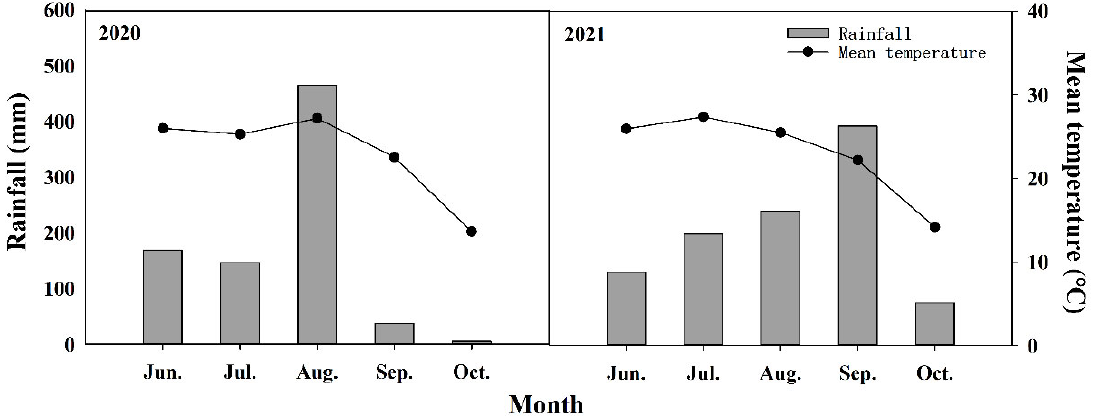
Figure 9. Rainfall and mean temperature during the experimental period.